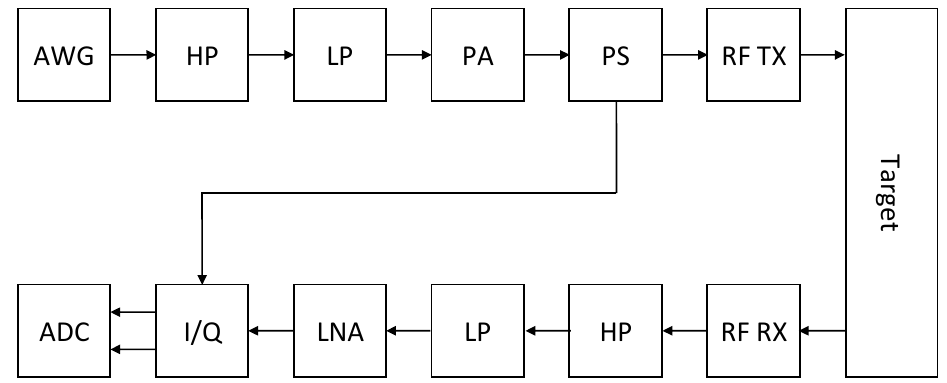
Figure 8. Block diagram of transmitter and receiver path, including generation and demodulation for abbreviations (see Table 2). Table 1. Macroscopic model parameters.